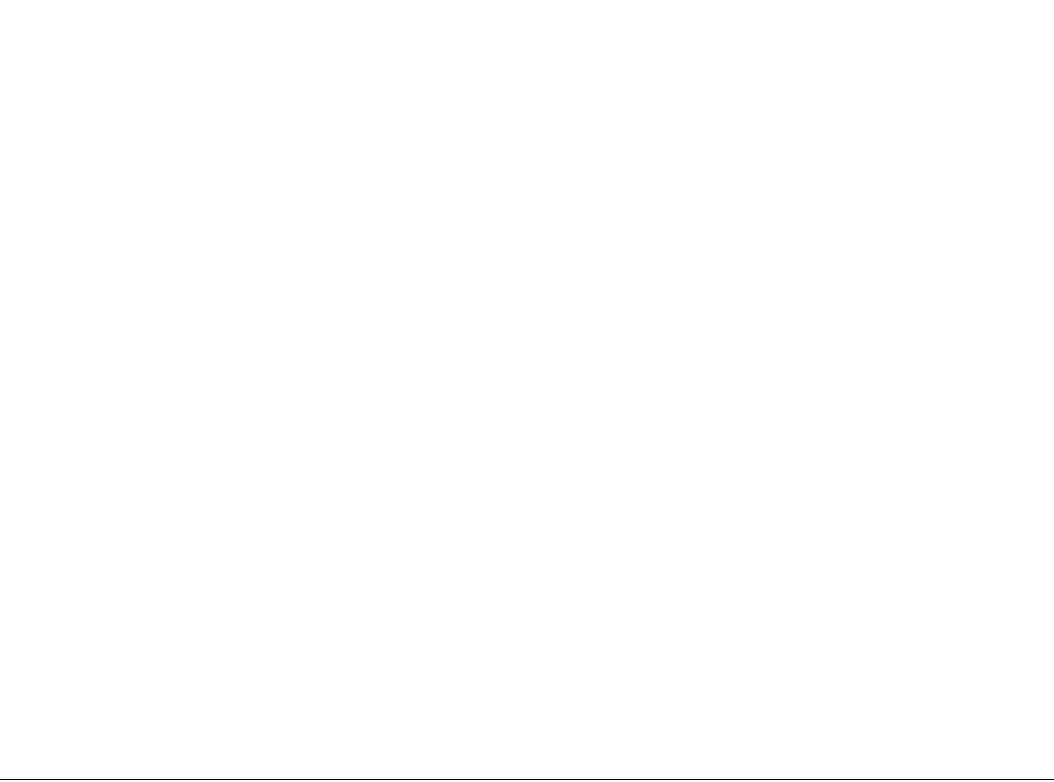
Table 4. Comparison for relative humidity and solar radiation data obtained by the AgroClimatic web application and by the Meteorological Data Service. RH: Relative Humidity. SR: Solar